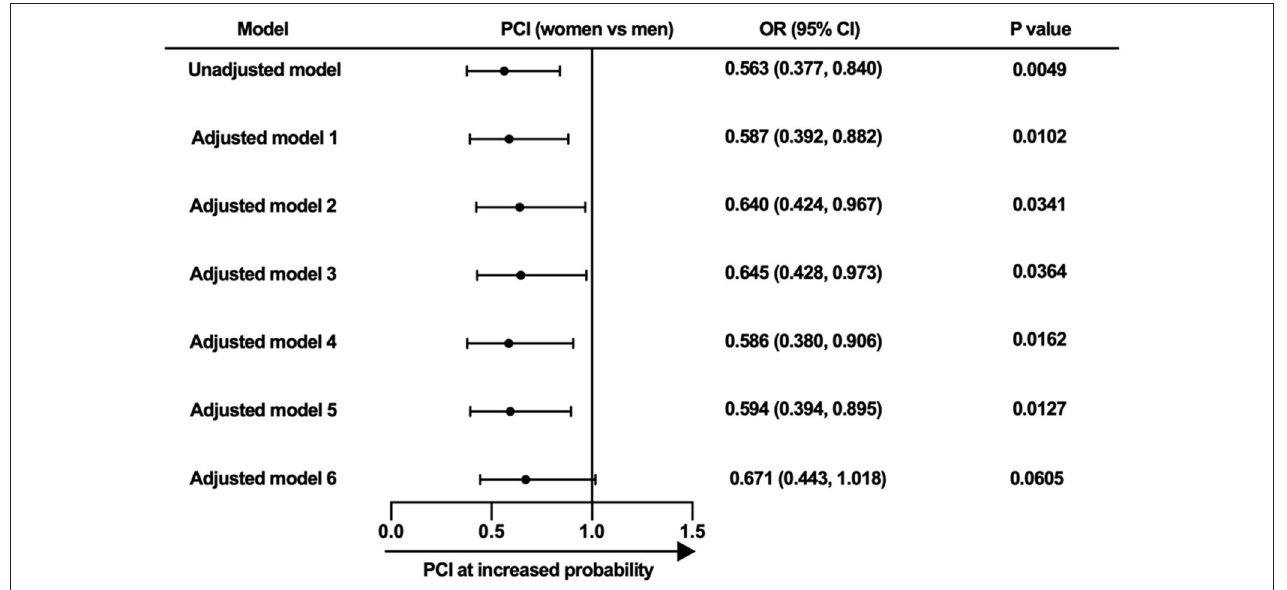
FIGURE 3 | Multivariate analysis for the likelihood of receiving PCI. Model 1, adjusted for symptom onset to admission time. Model 2, adjusted for symptom onset to admission time and education level. Model 3, adjusted for age, medical insurance, education level, living status, and body mass index. Model 4, adjusted for diabetes mellitus, hypertension, hyperlipidemia, smoking status, prior angina pectoris, prior myocardial infarction, prior heart failure, prior stroke, prior PCI, prior renal dysfunction, chronic obstructive pulmonary disease, and family history of premature coronary atherosclerosis heart disease. Model 5, adjusted for heart rate, systolic blood pressure, Killip grade, cardiac arrest at admission, diagnosis, and anterior wall involvement. Model 6, adjusted for age, medical insurance, education level, living status, body mass index, and symptom onset to admission time. PCI, percutaneous coronary intervention; OR, odds ratio; CI, confidence